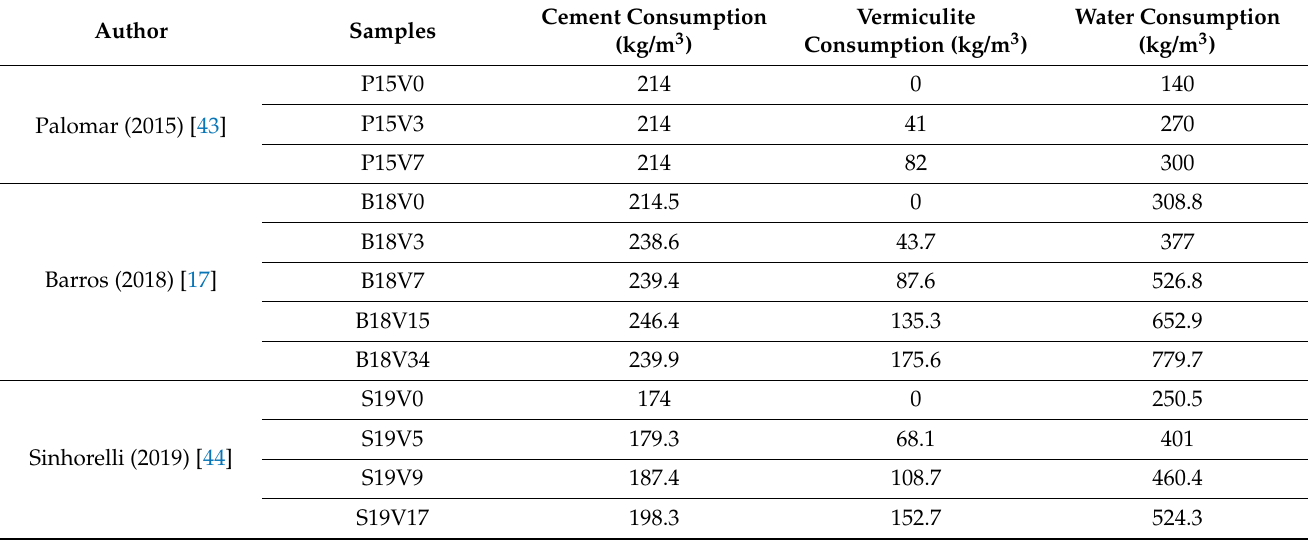
Table 6. Cement, vermiculite, and water consumption for mortars